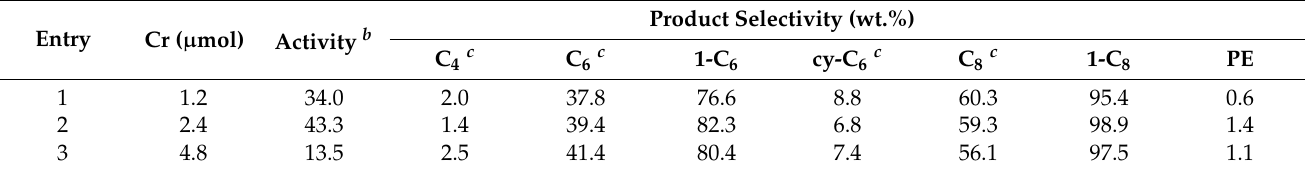
Table 6. Evaluation of the effect of mass loading on the catalytic performance of the L4-based catalyst a .